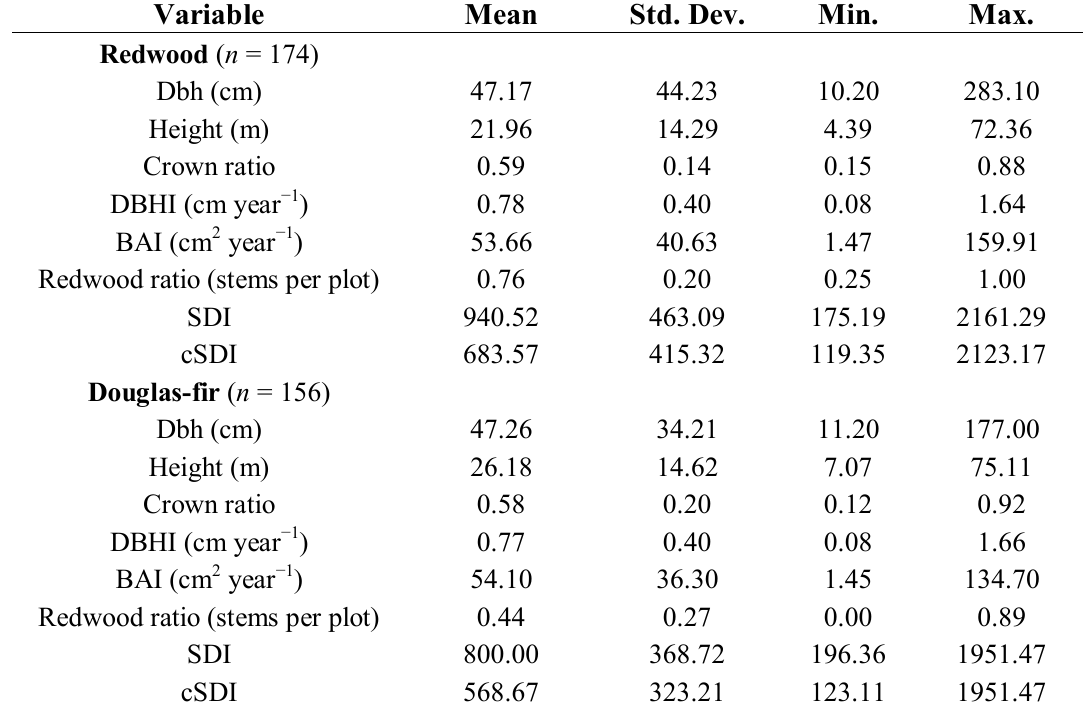
Table 4. Summary data for trees sampled for recent growth at Headwaters Forest